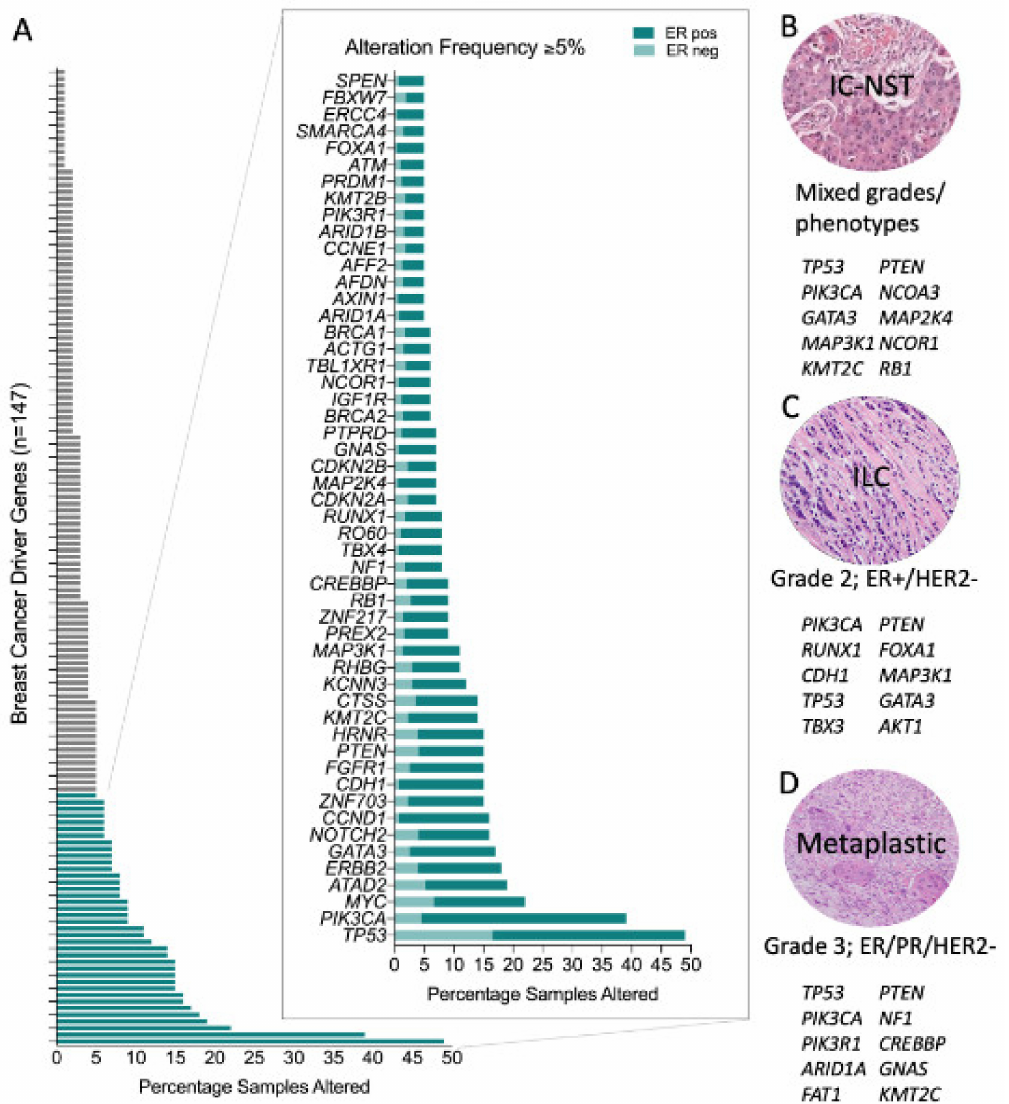
Figure 1. Genomic alterations across breast cancers. ( A ) Frequency of genomic alteration (mutation and copy number variation) in the 147 breast cancer driver genes across the TCGA pancancer breast cancer dataset ( n = 1033); and stratified by oestrogen receptor (ER) status (in magnified plot): ER positive, n = 795; ER negative, n = 238. Top ten most frequently mutated genes in ( B ) Invasive Carcinoma-No Special Type (IC-NST) [15]; ( C ) Invasive Lobular Carcinoma (ILC) [15]; and, ( D ) Metaplastic breast cancer